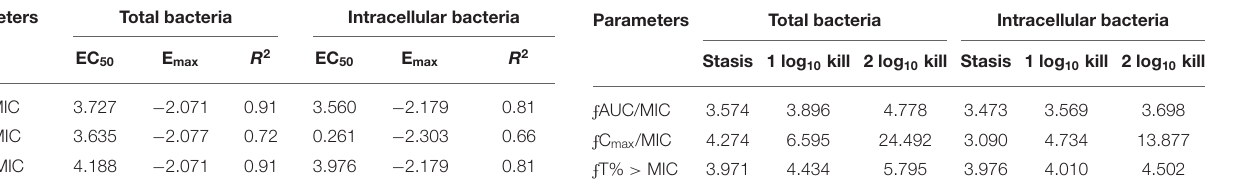
TABLE 4 | Parameters for mean Hill-curve fit for total bacteria and intracellular bacteria. Parameters